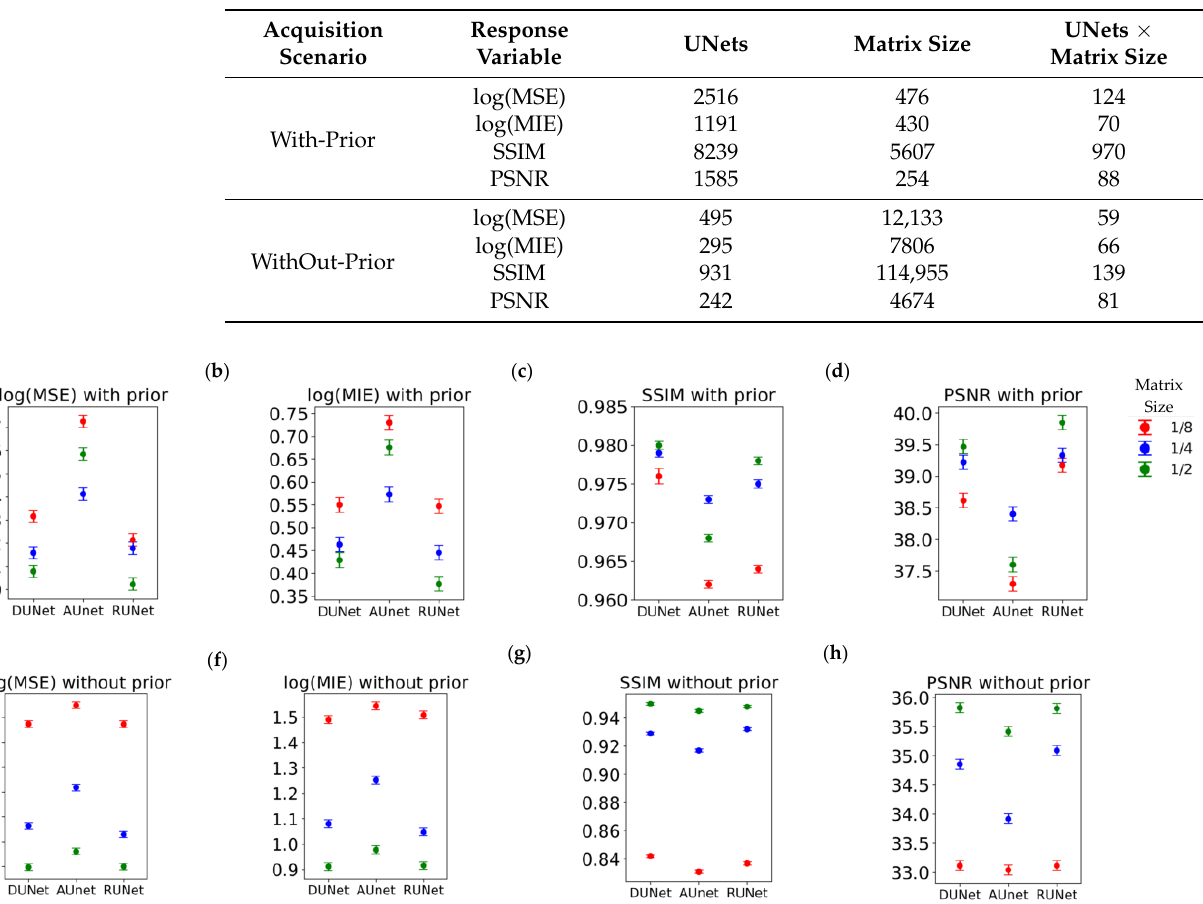
Table 4. F-ratios showing the significance of each of the terms that were used in the mixed effects model. Each term is highly statistically significant as all the F-ratios are large, resulting for all cases in p -values << 0.01.